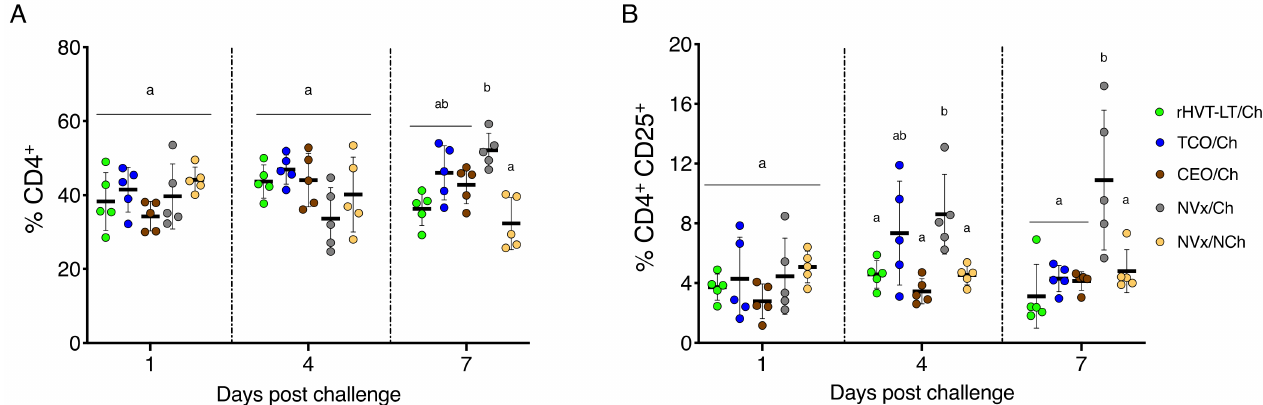
Figure 5. CD4 + T cells and Tregs in the larynx–trachea at 1, 4 and 7 dpch. ( A ) CD4 + T cells; ( B ) Tregs (CD4 + CD25 + ). Small horizontal lines indicate the mean ( ± SD). Each dot represents an individual chicken (n = 5 for each group). Different letters indicate significant differences ( p < 0.05).